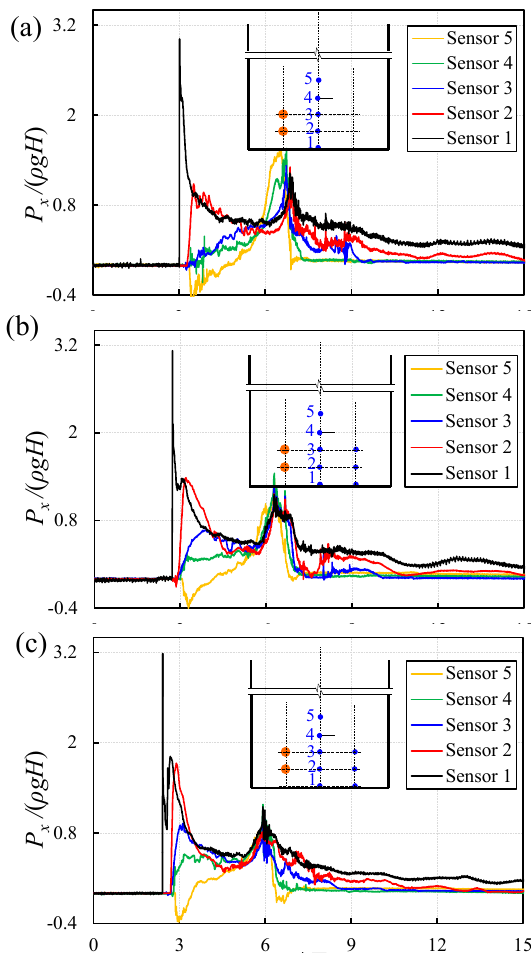
Figure 8 . Normalized horizontal dynamic pressure with non − -dimensionalized time: ( a ) H = 200 Figure 8. Normalized horizontal dynamic pressure with non-dimensionalized time: ( a ) H = 200 mm; mm; ( b ) H = 250 mm; ( c ) H = 300 mm. ( b ) H = 250 mm; ( c ) H = 300